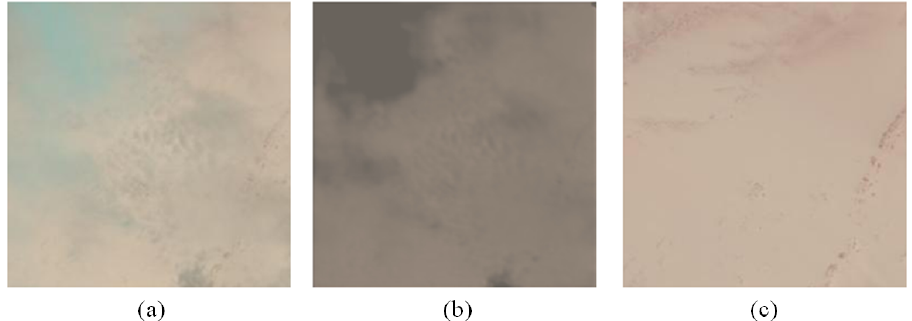
Figure 15. The result of removing heavy clouds and cloud shadows with poor performance: ( a ) input cloudy image, ( b ) reconstructed image by YUV-GAN, and ( c ) reference cloud-free image.